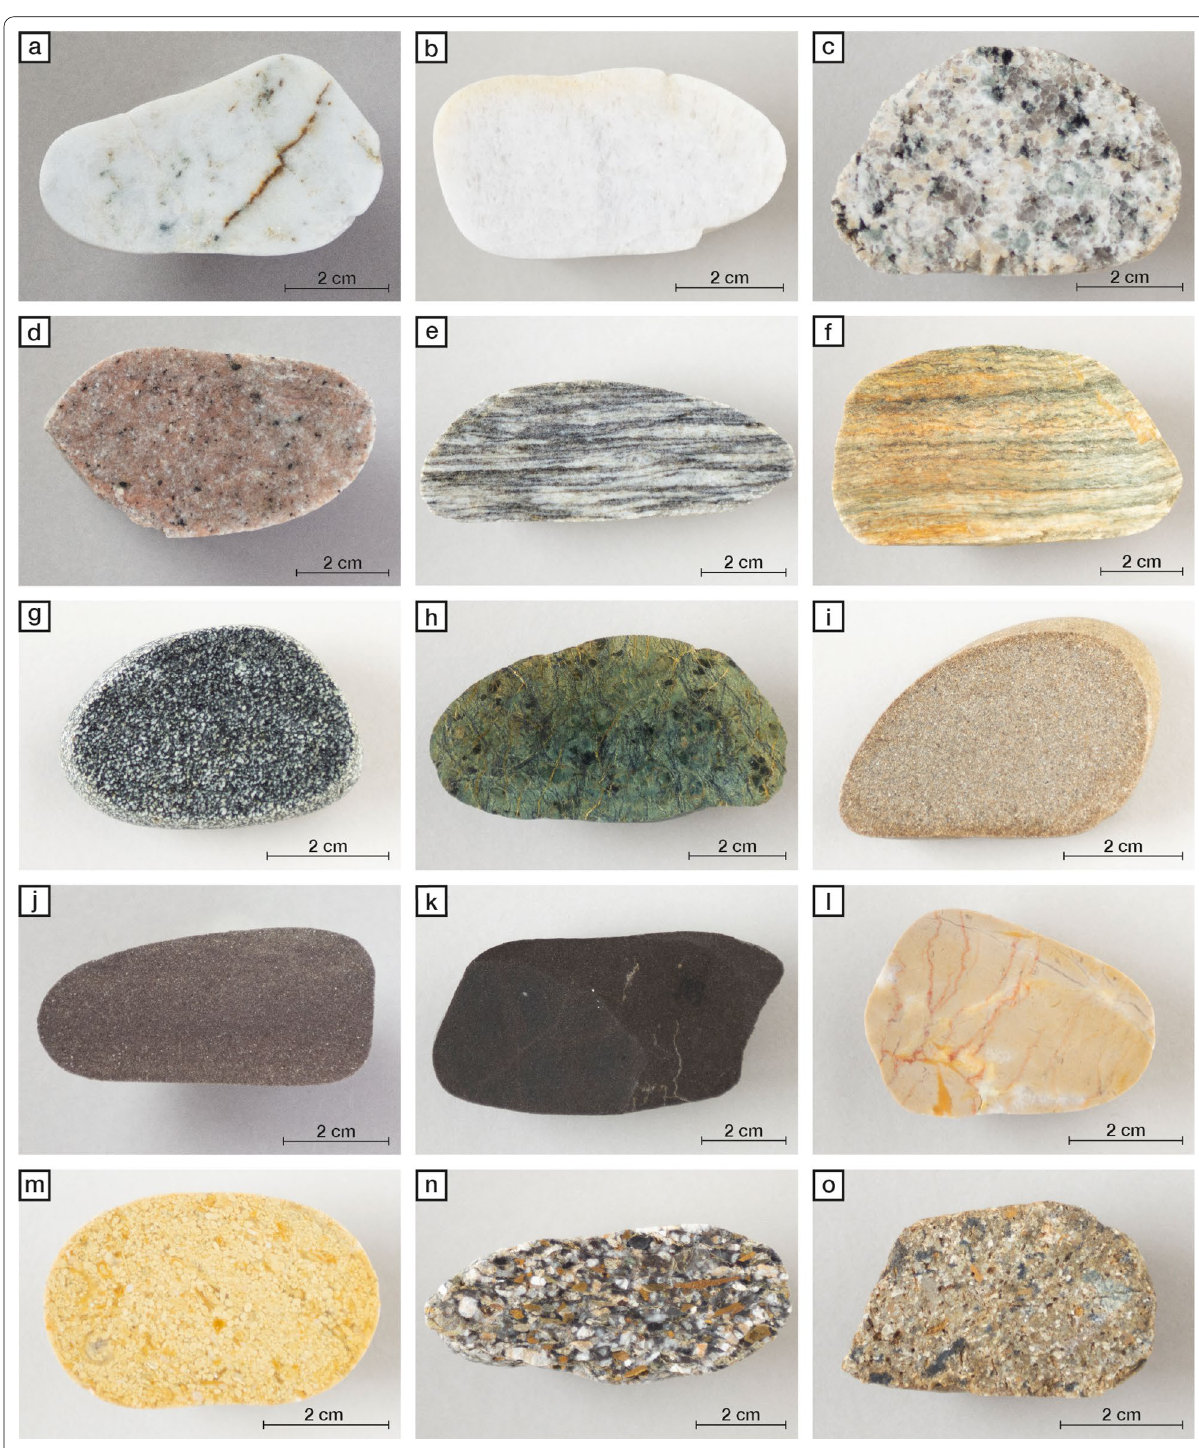
Fig. 3 Cut and polished pebbles from the Müntschemier and Finsterhennen pits. a Vein quartz, b Quartzite, c , d Granite, e , f Gneiss, g Amphibolite, h Serpentinite, i , j Sandstone, k Dark-coloured limestone, l Light-coloured limestone, m Oosparite, and n , o Niesen- and